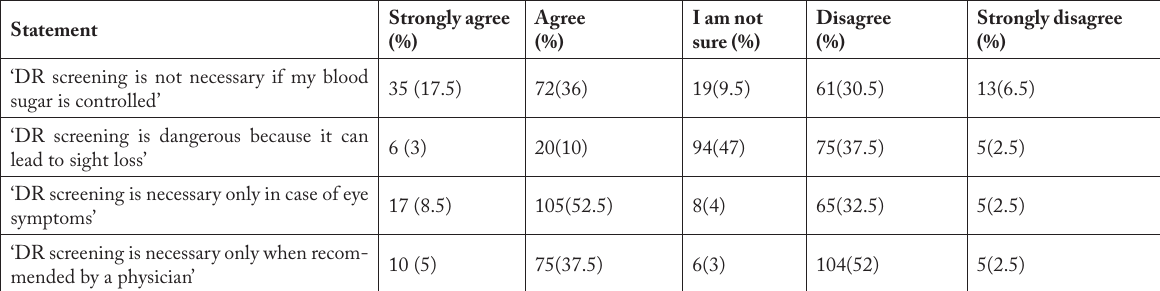
Figure 1. Level of knowledge of DM and DR amongst the Table 3. Respondents responses on attitude ( n = 200).